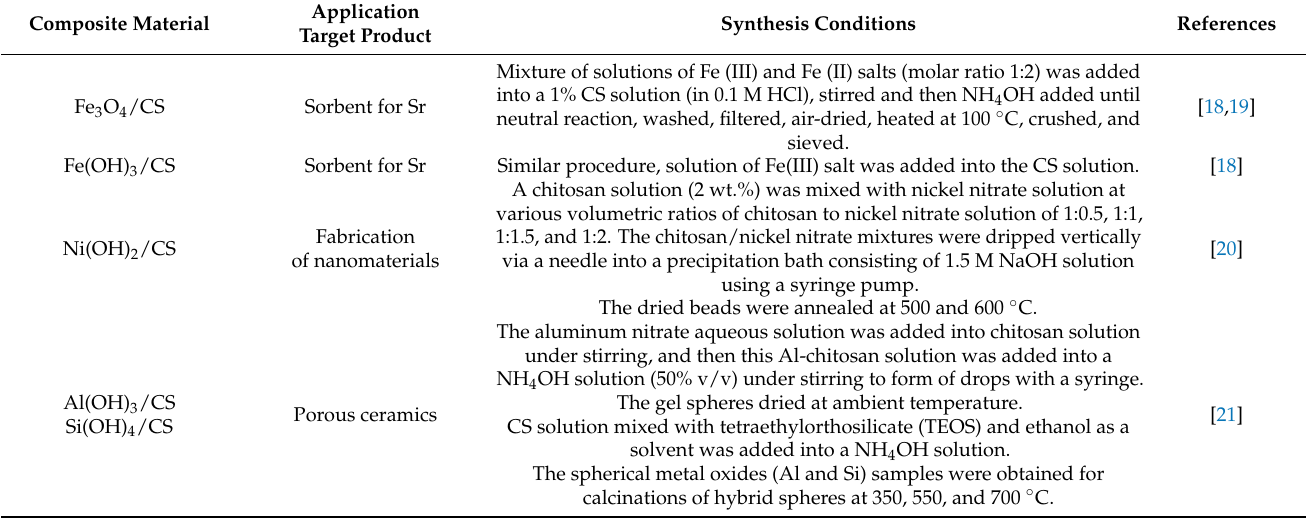
Table 1. Conditions for the formation of hybrid materials based on